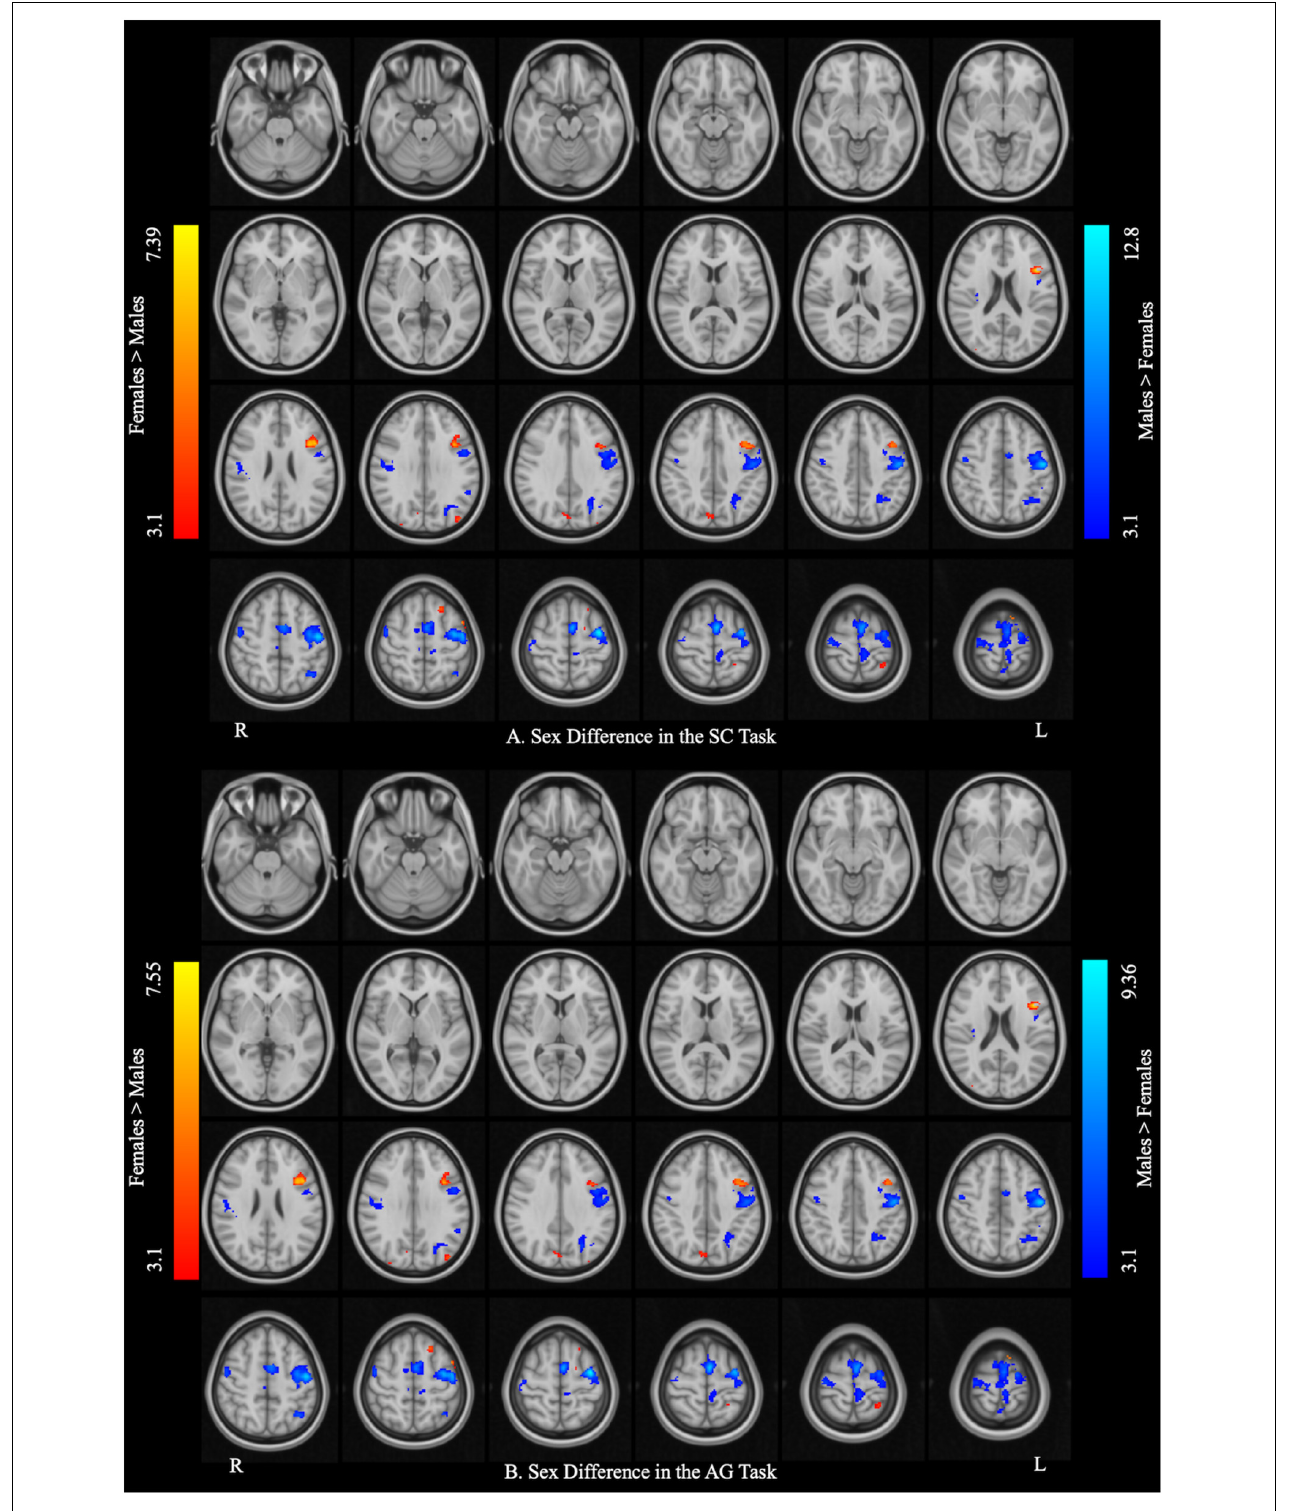
FIGURE 3 | Sex differences in each language task. (A) Sex difference in the sentence completion (SC) task. (B) Sex difference in the antonym generation (AG) task. The areas rendered by the red–yellow color scale indicate greater activation in females relative to males, whereas the areas rendered by the blue-light blue color scale indicate greater activation in males relative to females (Z-score > 3.1, cluster size > 150 voxels, corrected p < 0.05).